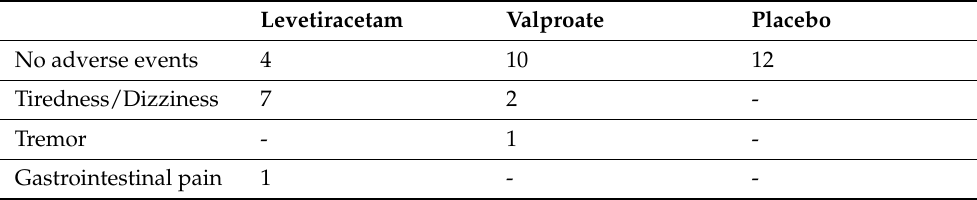
Table 3. Number of patients reporting adverse effects after the intake of the study